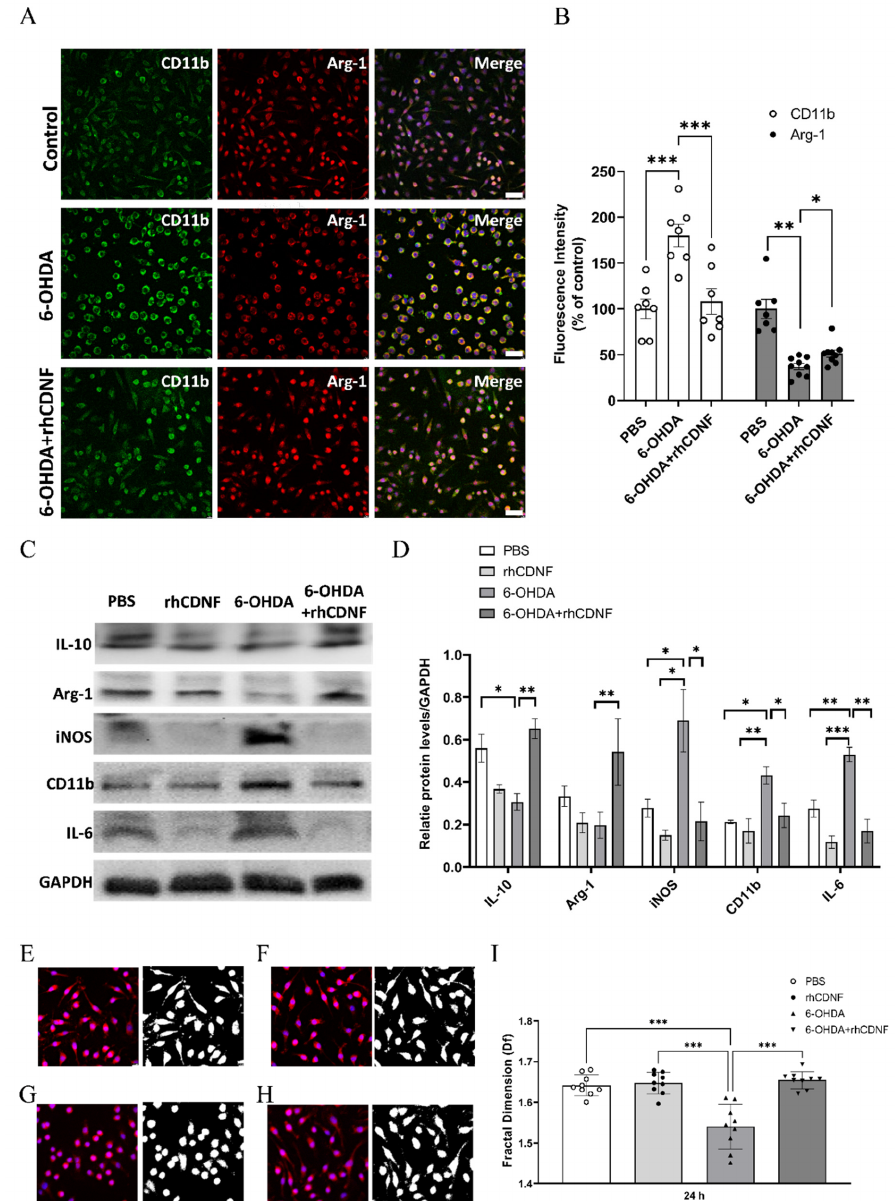
Figure 9. Effects of CDNF on 6 − OHDA − stimulated BV2 microglial cells. ( A ) Representative pictures of BV2 cells double-stained for CD11b (green) or Arginase − 1 (Arg − 1; red), and nuclei were counterstained with DAPI (blue). Photomicrographs were taken with an epifluorescence microscope; scale bar = 50 µ m. ( B ) The fluorescent intensities divided by the untreated BV2 cells (control group). There was an increase in CD11b fluorescent intensity in BV2 cells after 6 − OHDA treatment as compared with the untreated BV2 cells (control group), and rhCDNF given simultaneously with 6-OHDA decreased activated CD11b intensity in BV2 cells. In contrast, the fluorescent intensity of Arg-1 in 6-OHDA-stimulated BV2 cells was lower than the control group, which was upregulated by CDNF supplementation. ( C ) Lysates from BV2 cells after PBS, rhCDNF, 6-OHDA, or 6-OHDA + rhCDNF treatment were immunoblotted and IL10, Arg − 1, iNOS, CD11b, IL − 6, and GAPDH levels were analyzed. ( D ) Protein levels were quantified in relation to levels of GAPDH, a housekeeping protein (n = 5, mean ± S.E.M). ( E – H ) Morphological analysis of Iba1 − stained BV2 cells. The process to prepare photomicrographs for morphological analysis: Original photomicrographs were subjected to a series of uniform ImageJ plugin protocols prior to conversion to binary images. Binary